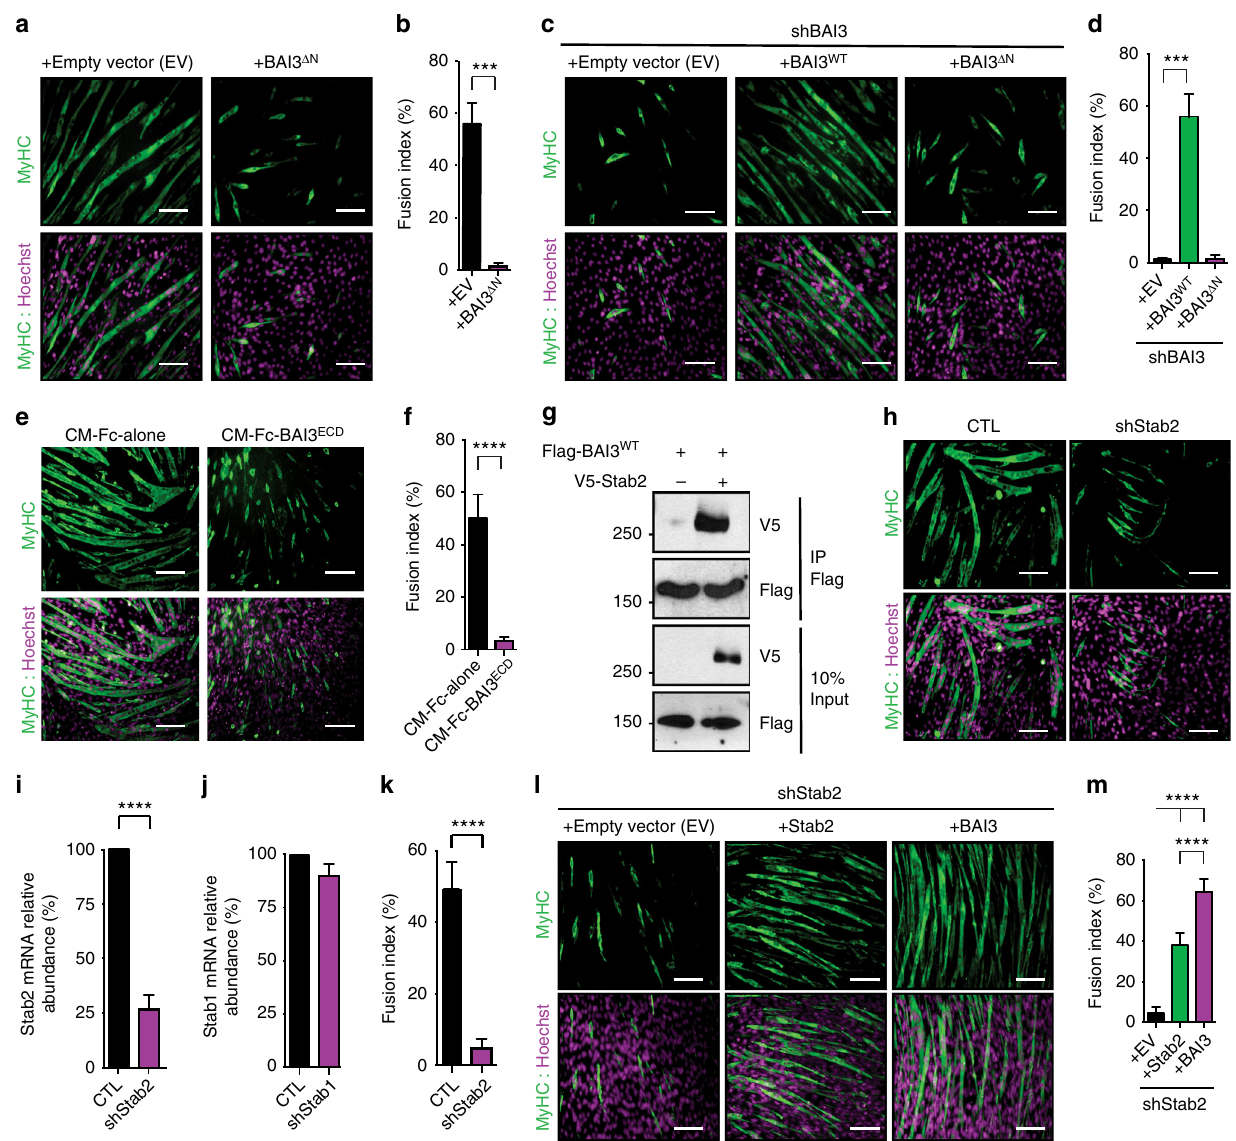
Fig. 5 Stabilin-2 is a binding partner of BAI3. a A BAI3 mutant lacking the extracellular domain (BAI3 Δ N ) is defective to promote myoblast fusion. Expression of Flag-BAI3 Δ N blocks myoblast fusion in parental C2C12 cells. b Quanti fi cation of experiments shown in a . c Re-expression of Flag-BAI3 Δ N is unable to restore myoblast fusion in C2C12 cells depleted of endogenous BAI3. d Quanti fi cation of experiments shown in c . e The BAI3 ECD acts as a decoy receptor. C2C12 treated with Fc-BAI3 ECD -conditioned media, but not Fc-alone, display a block in myoblast fusion. f Quanti fi cation of the experiment shown in e . g Immunoprecipitation of Flag-BAI3 was carried out to assess its interaction with full length V5-Stabilin-2. h – k C2C12 cells expressing GFP or shRNA targeting Stabilin-2 were generated by retroviral infections. h Downregulation of Stabilin-2 decreases myoblast fusion after 48 h differentiation condition. i , j Real-time Q-RT-PCR ampli fi cations of Stabilin-1 and Stabilin-2 were performed to con fi rm the speci fi city of the knockdowns. k Quanti fi cation of experiments shown in h . l Fusion of C2C12 cells depleted of Stabilin-2 (shStab2) is restored following expression of either human V5-Stabilin-2 or Flag- BAI3. m Quanti fi cation of experiments shown in l . Myo fi bers were stained for Myosin Heavy Chain (MyHC, MF20 antibody (green)) and nuclei were revealed by Hoechst (purple). Error bars indicate standard deviation. Scale bar = 100 μ m. One-way ANOVA followed by a Bonferroni test was used to calculate the P- values; *** P < 0.001, **** P <